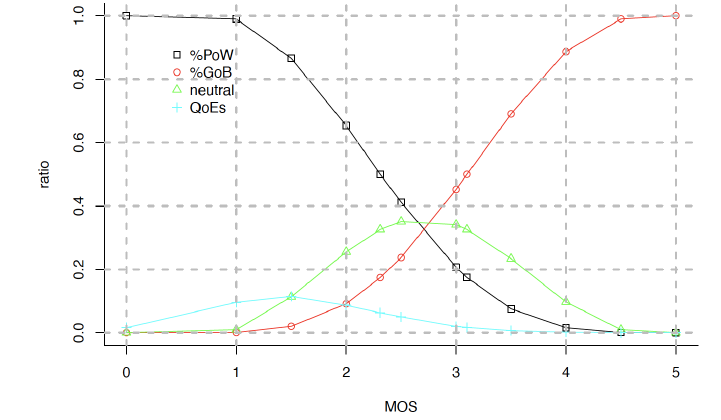
Figure 6. Relationship between MOS , % PoW , % GoB , and QoE s . We compare the relationship between the MOS, %PoW, %GoB as used in the E-model, with the probability density function of the QoE mined from the spreading dynamics of user experience in M during T temporal